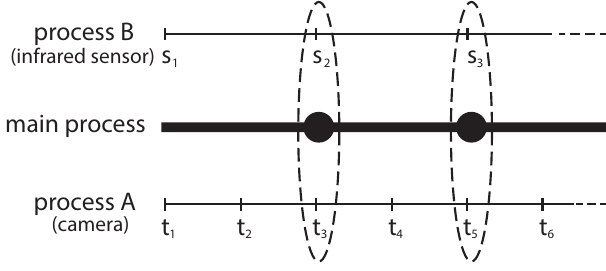
Figure 1. Usage of timestamps.